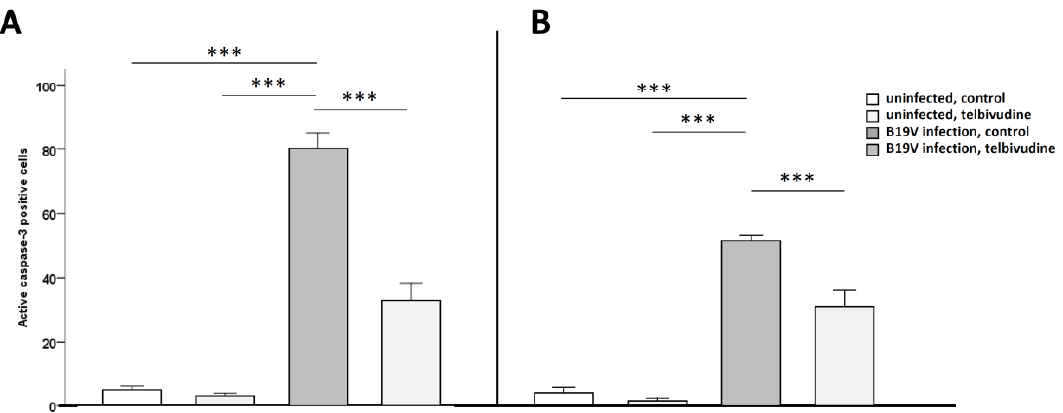
Figure 1. Reduced human parvovirus B19 (B19V)-induced apoptosis after telbivudine pre-treatment in B19V-infected early outgrowth endothelial progenitor cells (eo-EPC) and endothelial colony-forming cells (ECFC). Quantification of active caspase-3 positive in ( A ) ECFC and ( B ) eo-EPC. Data are means +SD, *** is p < 0.001.